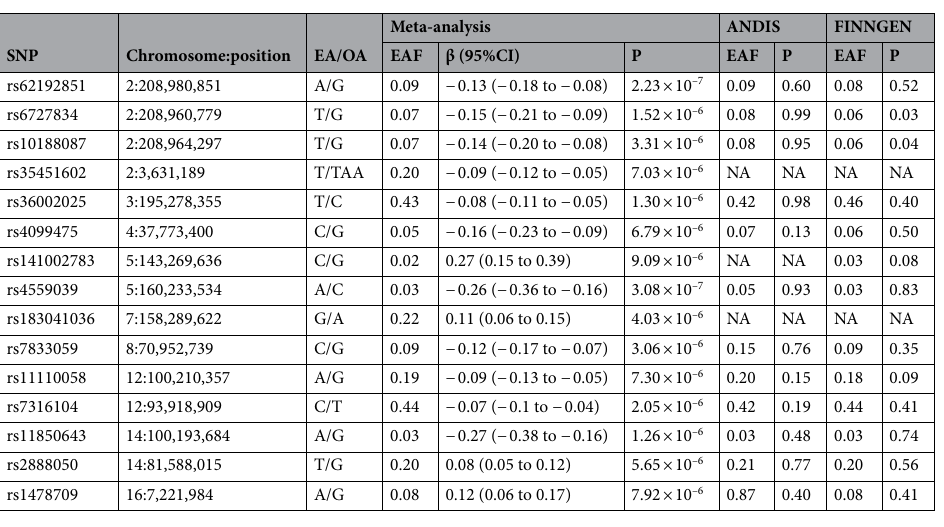
Table 3. Replication of the top loci (P < 1 × 10–5) in the ANDIS (individuals with type 1 and type 2 diabetes) and the FinnGen (individuals without diabetes) replication cohorts. Table shows the top variant from the GWAS meta-analysis in each locus, as well as two additional variants that replicated in the FinnGen-cohort (rs6727834 and rs10188087 in the chromosome 2 locus). SNP single nucleotide polymorphism, EA/OA effect allele/other allele, EAF effect allele frequency, NA not